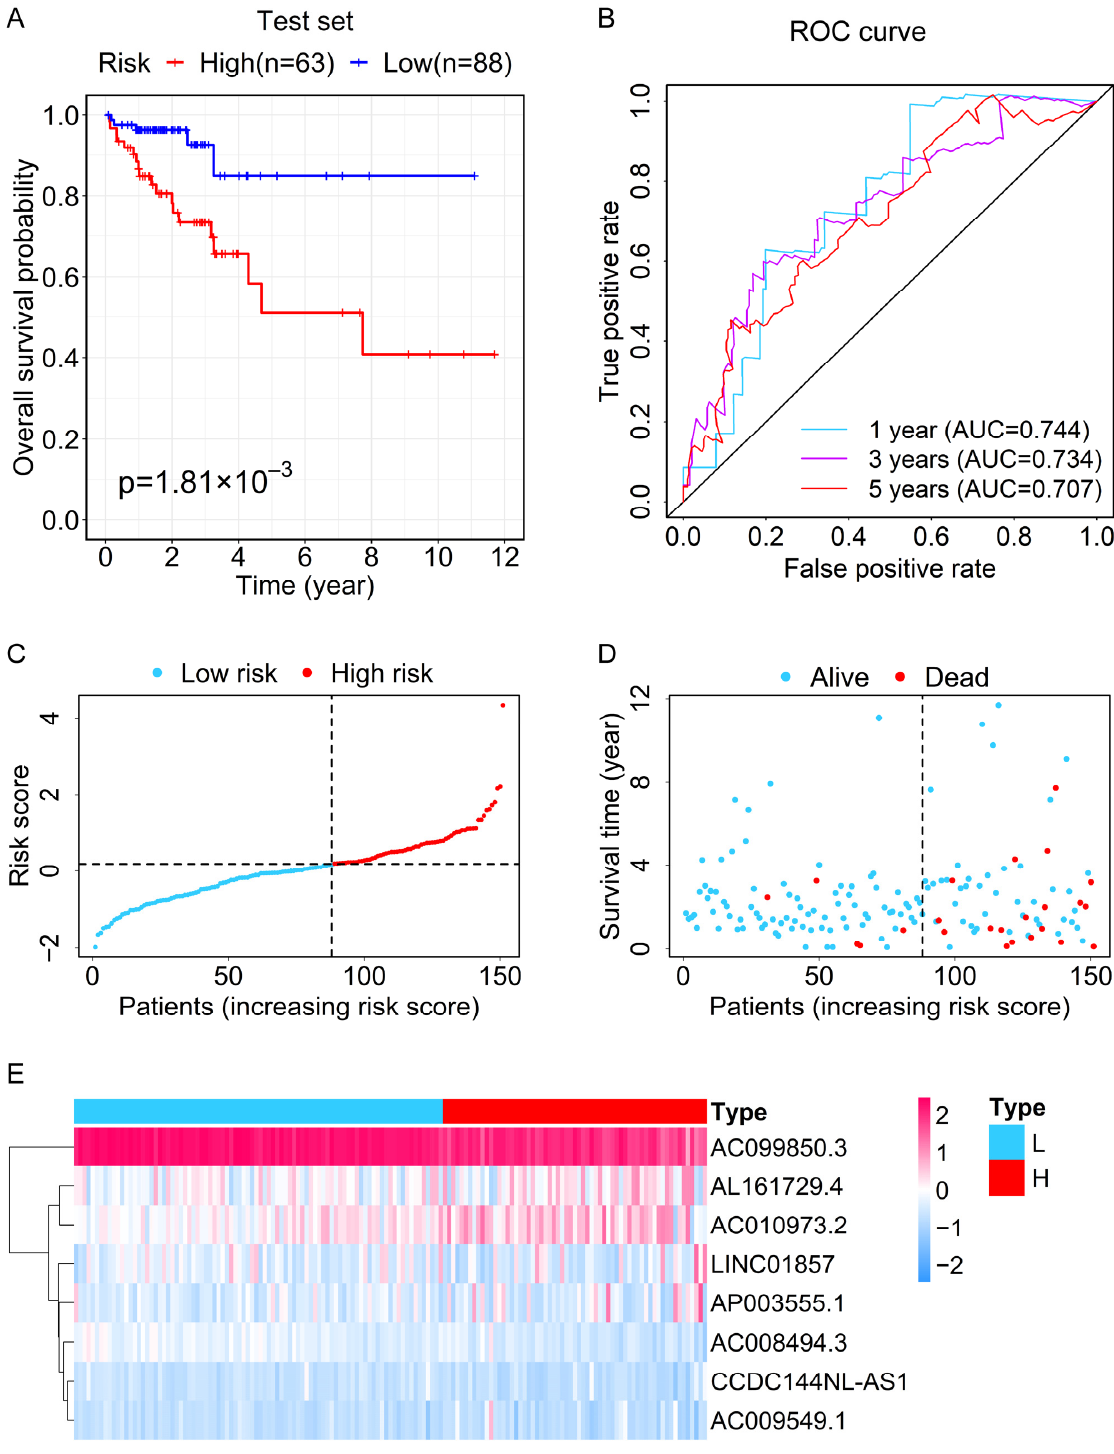
Figure 3. Validation for the prognostic value of the lncRNA signature in the test set ( A ) Kaplan–Meier survival curve for OS of CRC patients in the high- and low-risk groups. ( B ) The time-dependent ROC curves of OS based on the risk score indicate the prognostic accuracy of the 8-lncRNAs signature. ( C ) The distribution of risk scores of CRC patients. ( D ) The scatter plot shows the overall survival time and survival status of CRC patients in the high- and low-risk groups. ( E ) Heatmap of clustering analysis for the expression of eight ferroptosis-related lncRNAs in the high- and low-risk groups. L, low risk; H, high